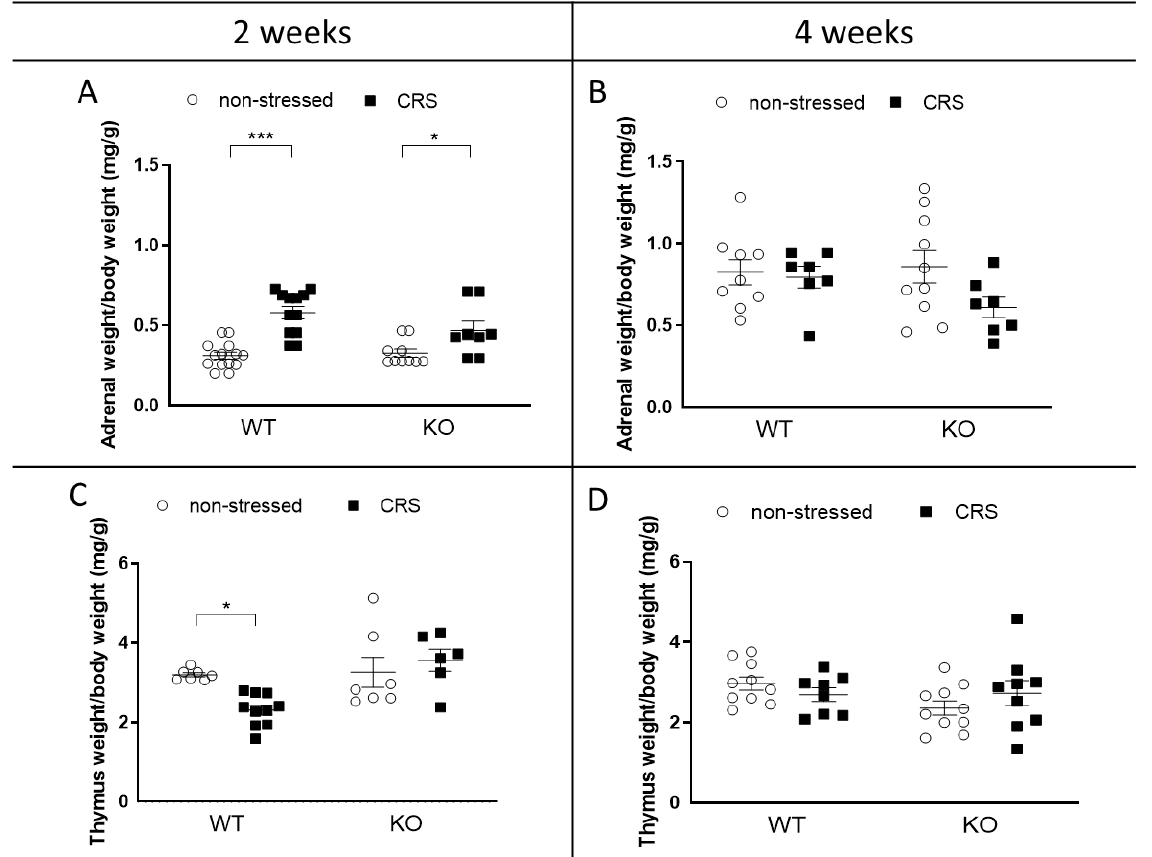
Figure 3. Chronic restraint stress (CRS)-induced weight changes of stress-sensitive organs in wild- type (WT) and Interleukine-1 knock-out (KO) female animals. Thymus weights after 2 weeks ( A ) and 4 weeks ( B ); adrenal gland weights after 2 weeks ( C ) and 4 weeks ( D ) of CRS. Data are presented as the means ± SEM of n = 6–12 animals with individual plots; two-way analysis of variance (ANOVA), followed by Tukey’s tests; * p < 0.05, *** p < 0.001 vs. respective control group. 2.4. CRS-Induced Immobility Decreases in KO but Not in WT Mice after 2 Weeks of CRS 2.4.1. Depression-like Behavior Changes following CRS in Female Animals After 2 weeks, a significant immobility time drop was detectable in the IL-1 KO, due to stress in both the Forced swim test (FST) and Tail suspension test (TST) (Figure 4A,C). This drop did not reach the level of significance in the WT groups. After 4 weeks, this difference between the four groups vanished in both tests (Figure